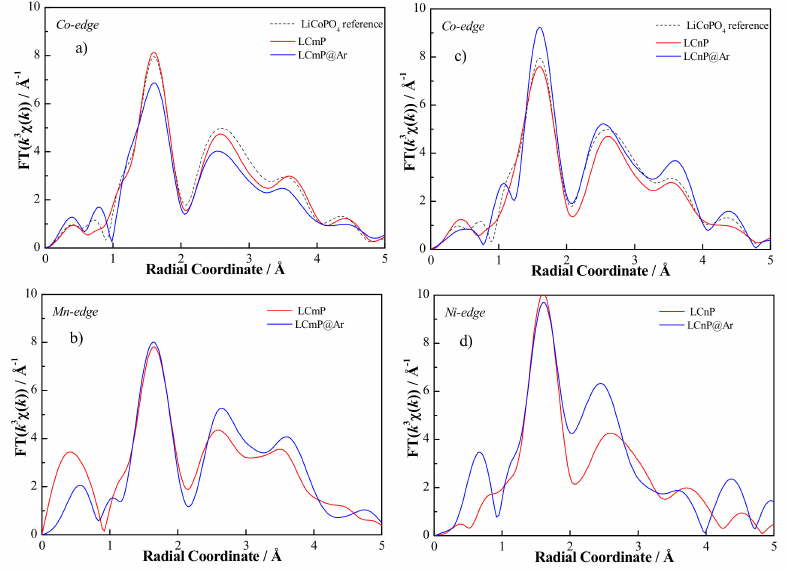
Figure 4. Radial distribution functions obtained after the Fourier transformation of k 3 χ ( k) : ( a ) Co-edge and ( b ) Mn-edge of LCmP and LCmP@Ar samples; ( c ) Co-edge and ( d ) Ni-edge of the LCnP and LCnP@Ar samples. In the case of the Co edges a reference radial distribution function is shown corresponding to the undoped LiCoPO 4 lattice